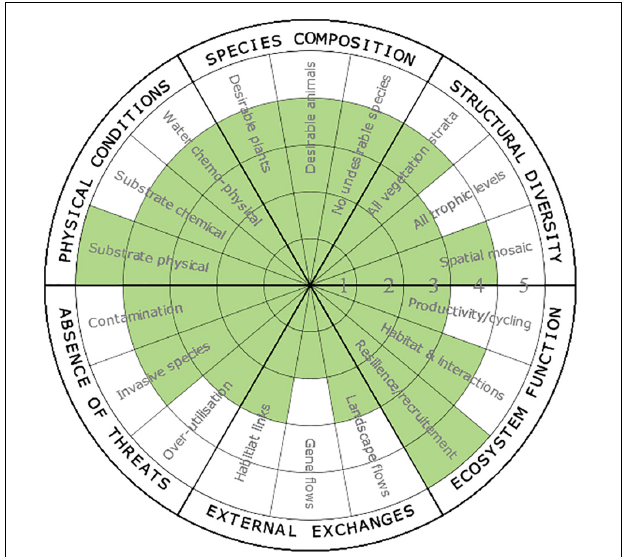
FIGURE 4 | Case study: Assessment of ecosystem recovery by Operation Crayweed using the SER 5-star recovery wheel. Average overall score is 3.7. Conducted by Operation Crayweed researchers (MAC, EMM, PDS, and AV). Individual attribute scores can range from 1 (e.g., biogenic structure restored, and ongoing deterioration prevented, but limited recovery of ecosystem attributes) through to 5 (e.g., restoration has re-established biota and functions that can continue a recovery trajectory without active interventions) (also see McDonald et al., 2016). Ratings are based on both monitoring and scientific publications, as well as expert opinion of the scientists and practitioners involved in